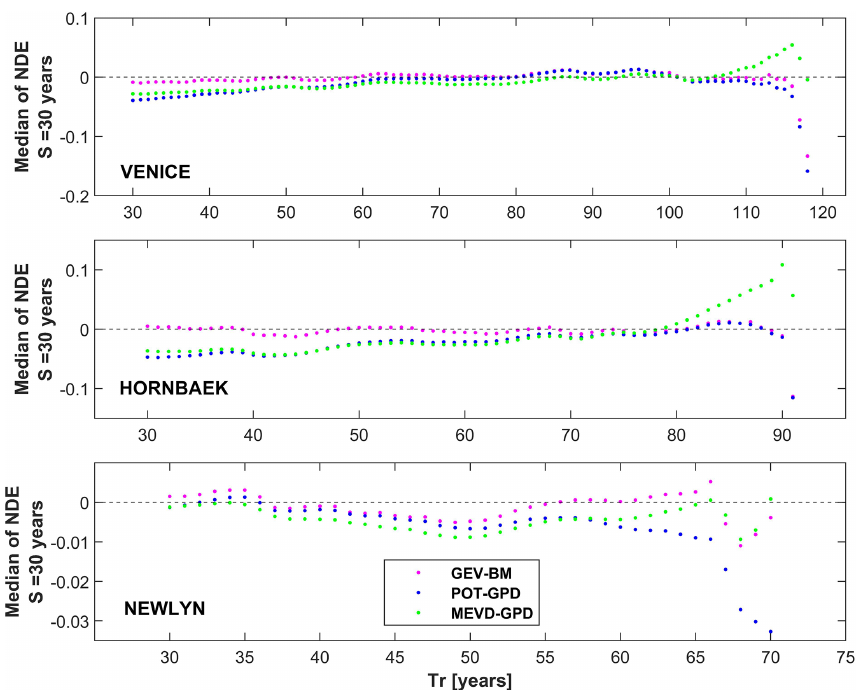
Figure 6. Median of the nondimensional error (NDE) for return period greater than the calibration sample size in test sub-sample for the GEV–BM, POT–GPD, and MEVD approaches (magenta, blue, and green dots, respectively). The results are obtained for the Venice (IT), Hornbæk (DK), and Newlyn (UK) sites and by estimating the distribution parameters on 30-year calibration sub-samples.